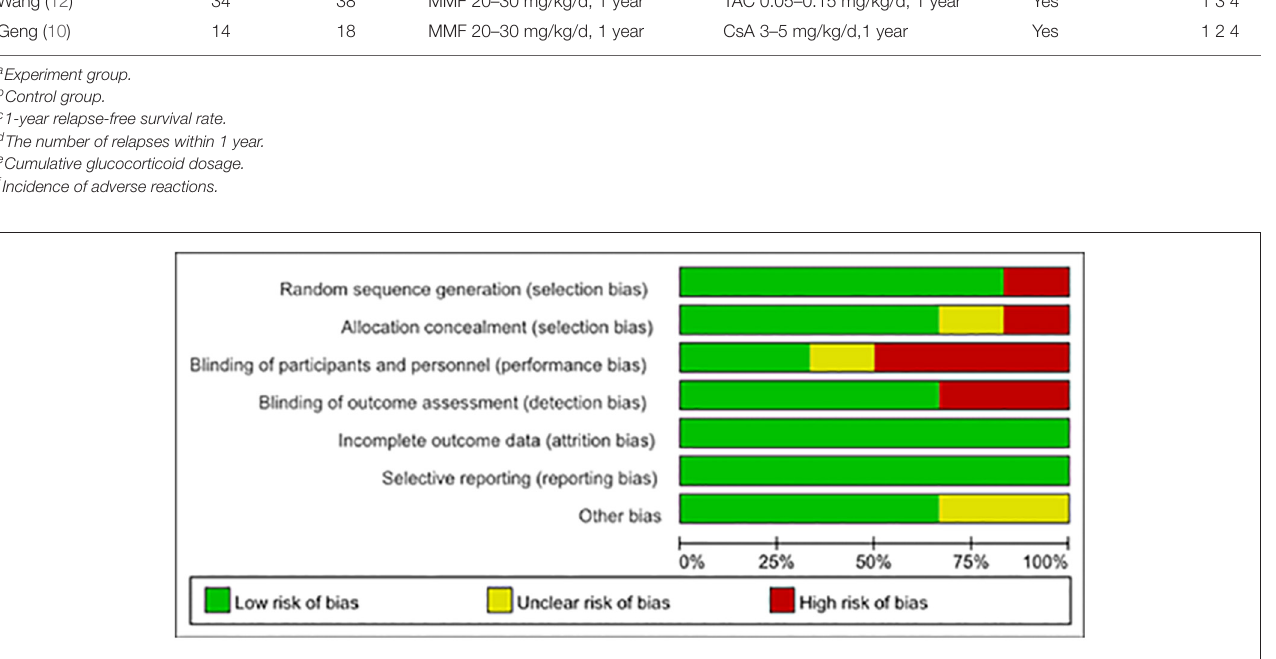
FIGURE 2 | Inclusion